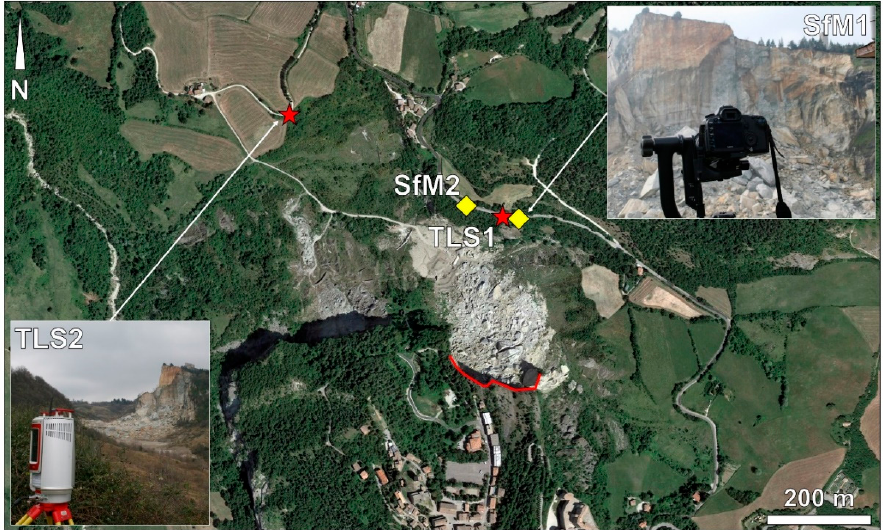
Figure 4. 2019 Google Earth satellite image showing the remote sensing stations. Red stars identify the TLS stations. Yellow diamond mark SfM camera locations. Insets shows the view from location SfM1 and TLS2.